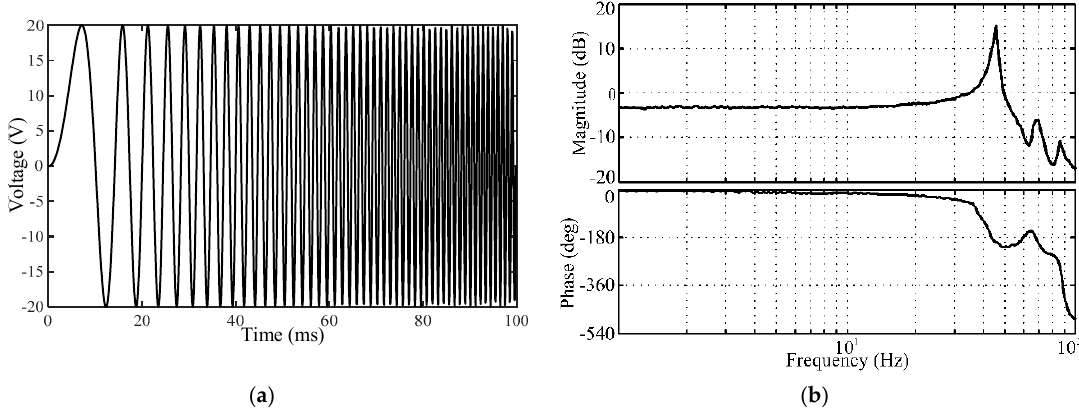
Figure 16. Frequency response of the compliant platform: ( a ) Sweep signal waveform; ( b ) frequency response along the X/Y -axis.